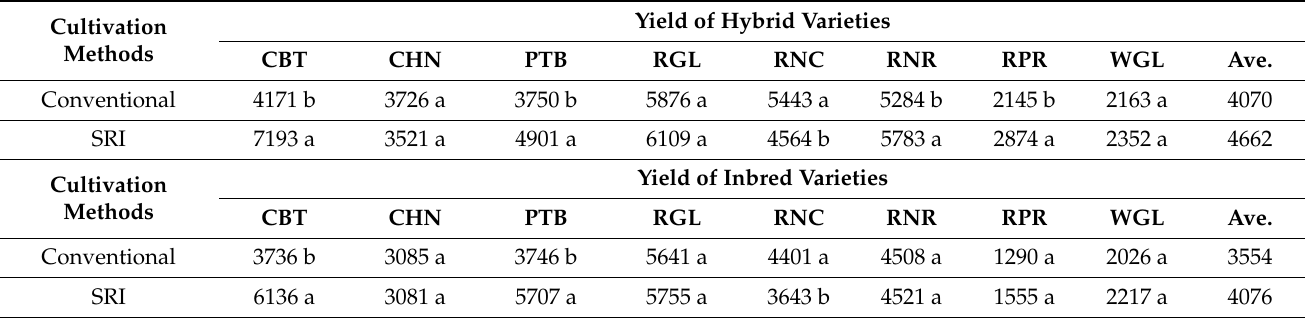
Table 2. Grain yield recorded in cultivation methods (kg ha − 1 ).